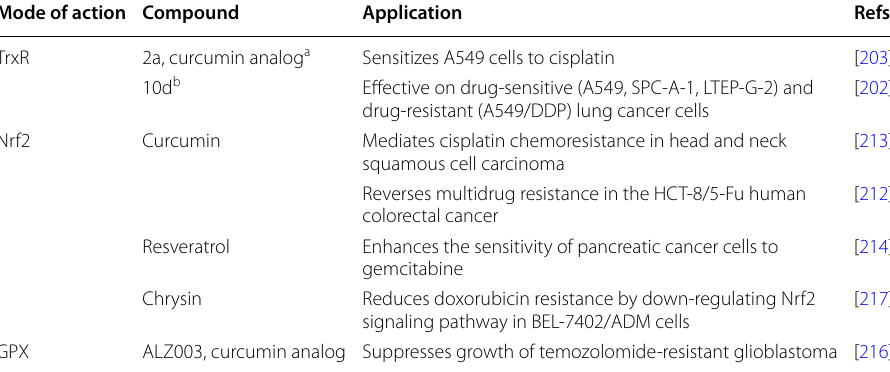
a (1E,4Z,6E)-5-hydroxy-1-(4-hydroxy-3-methoxyphenyl)-7-(5-methylfuran-2-yl)hepta-1,4,6-trien-3-one (2a) b Active compound of 21 ligustrazine-curcumin hybrids (10a-u)